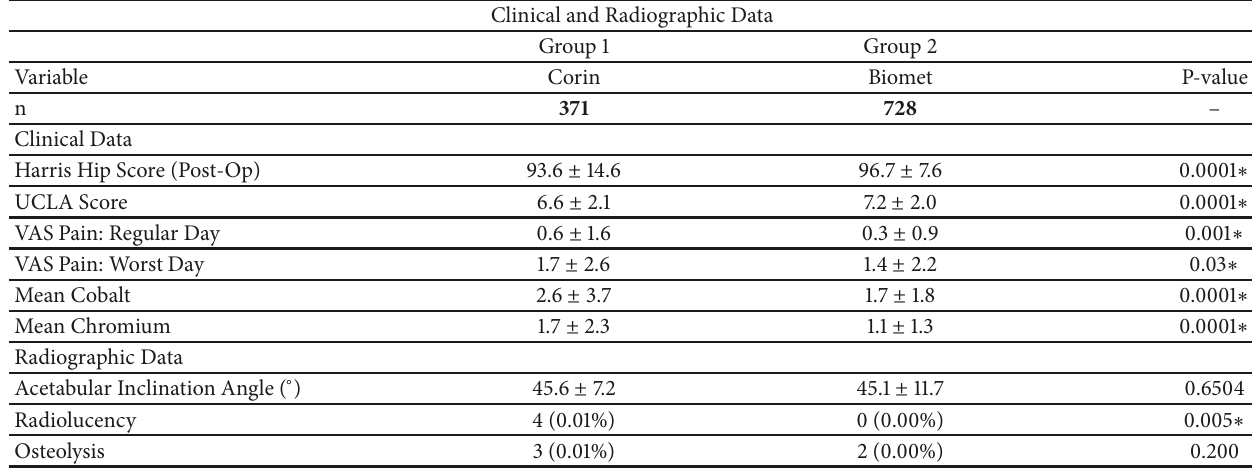
Table 5: Clinical and radiographic data.